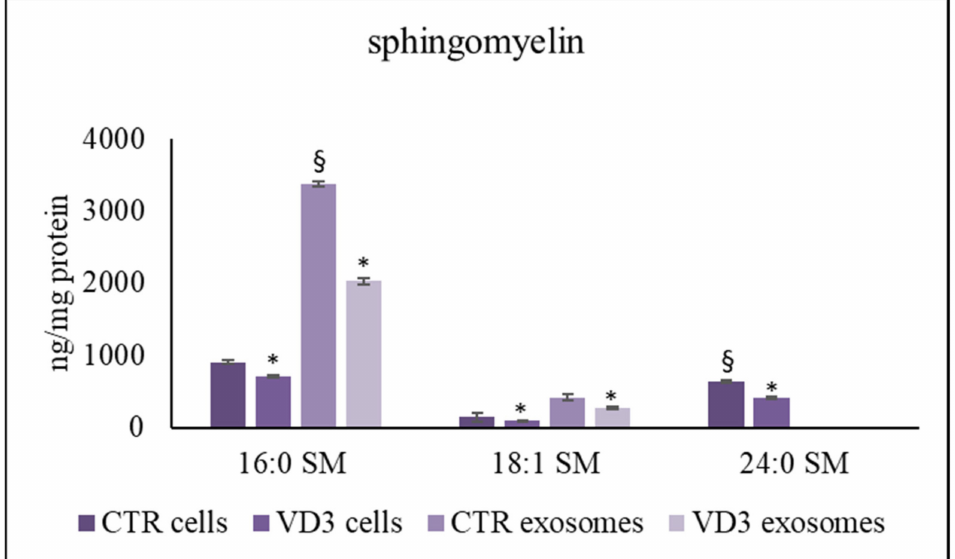
Figure 3. UFLC MS/MS analysis of SM species in cells and exosomes. The analysis was performed as reported in the Section 4. Data are expressed as ng/mg protein and represent the mean ± SD of three independent experiments performed in duplicate (case number: 6). * p < 0.05 versus the control sample, § p < 0.05 versus cells CTR, control sample; VD3, vitamin D3